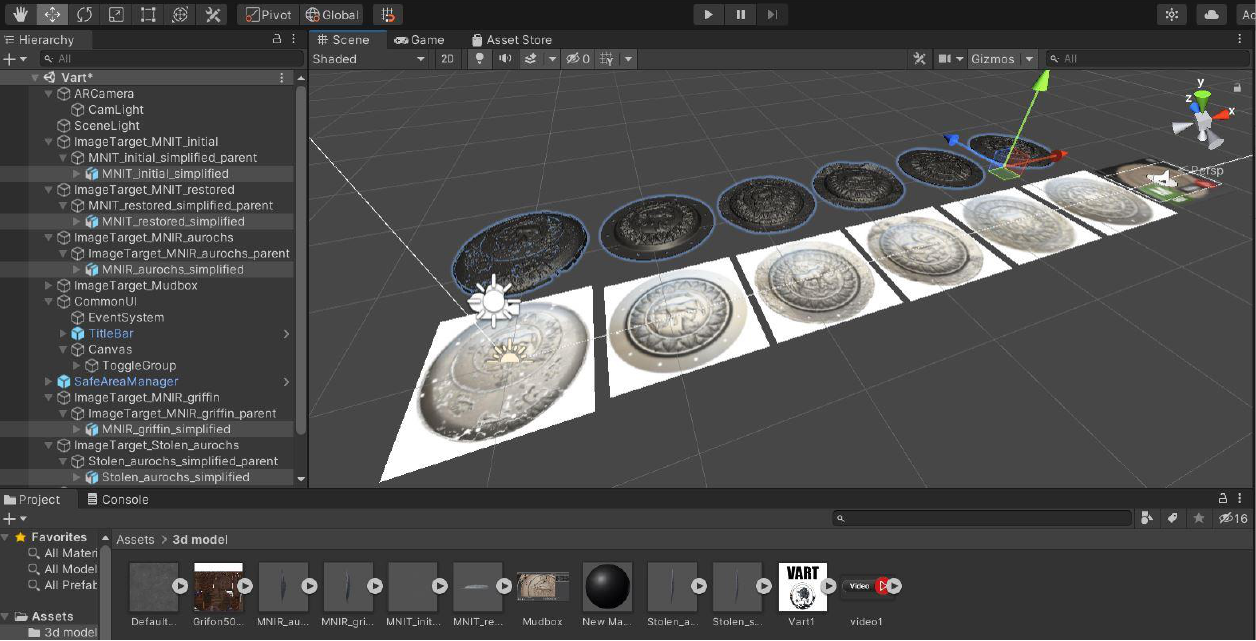
Figure 26. Overview of the augmented reality developed in Unity using Vuforia Engine.